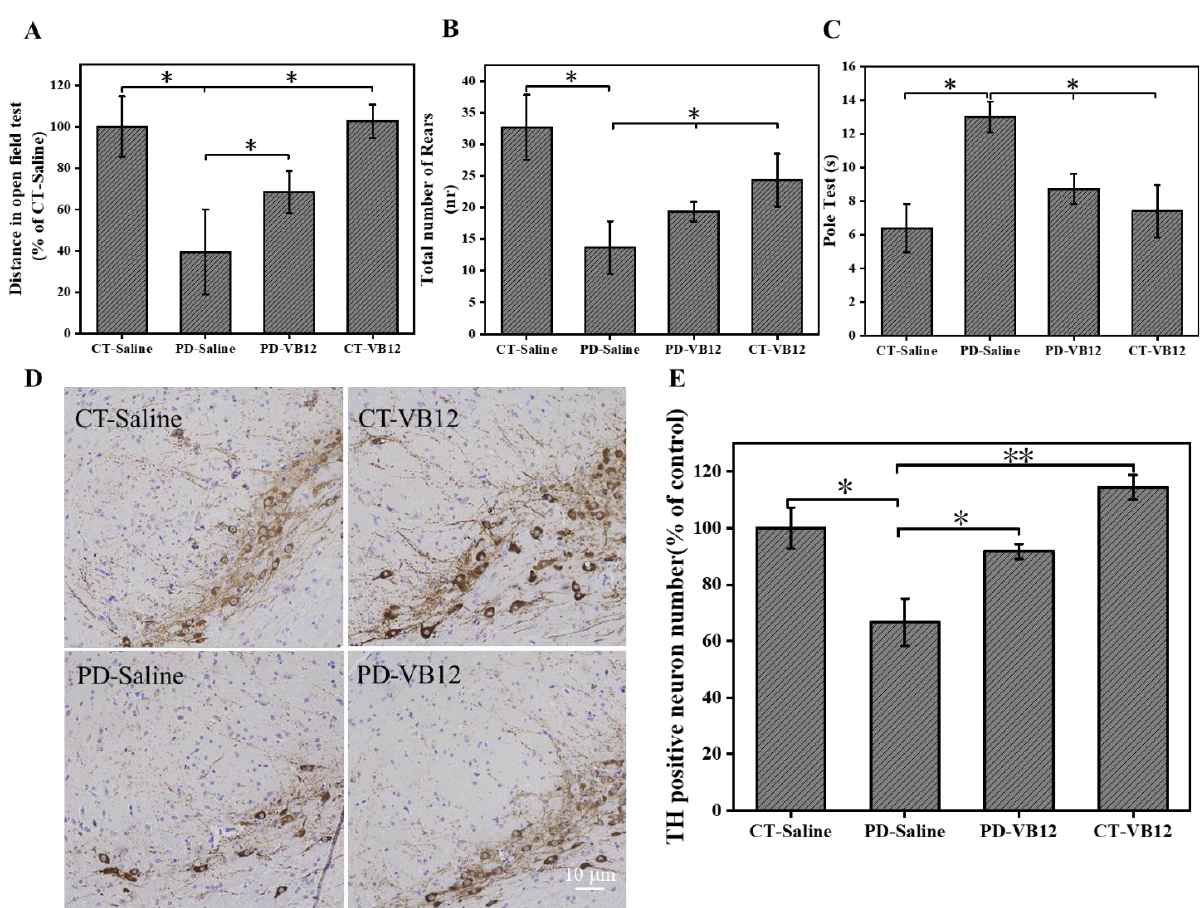
Figure 6. VB12 alleviated behavioral deficits and DA neuron loss in PD mice. ( A ) Open field assay to show the ambulation distance and ( B ) rearing frequency of mice; ( C ) pole test to show the move- ment coordination of mice; ( D ) representative TH immunohistochemistry staining of DA neurons of SN neurons of PD; ( E ) quantification of TH neurons number by ImageJ. Scale bar = 10 µ m. Data are the mean ± SEM, n = 4. * p < 0.05, ** p < 0.01 compared with other groups.